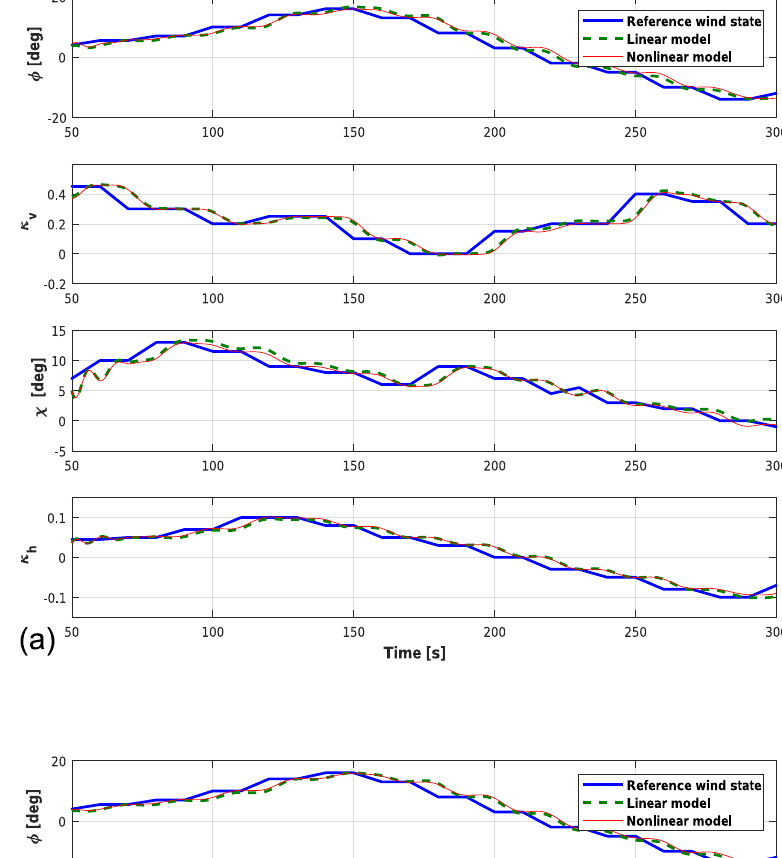
lines: real wind parameters; dashed thick green lines: observations by the linear model; solid thin red lines: observations by the nonlinear